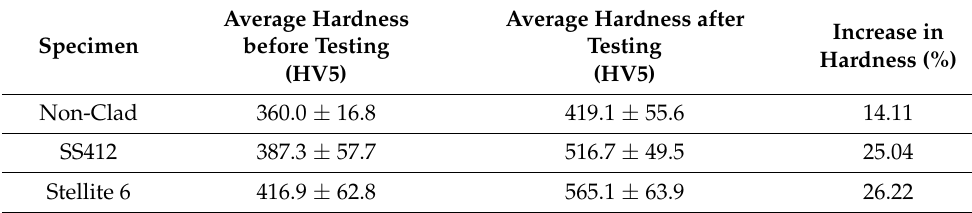
Table 5. Hardness for non-clad and cladded light rails before and after testing.